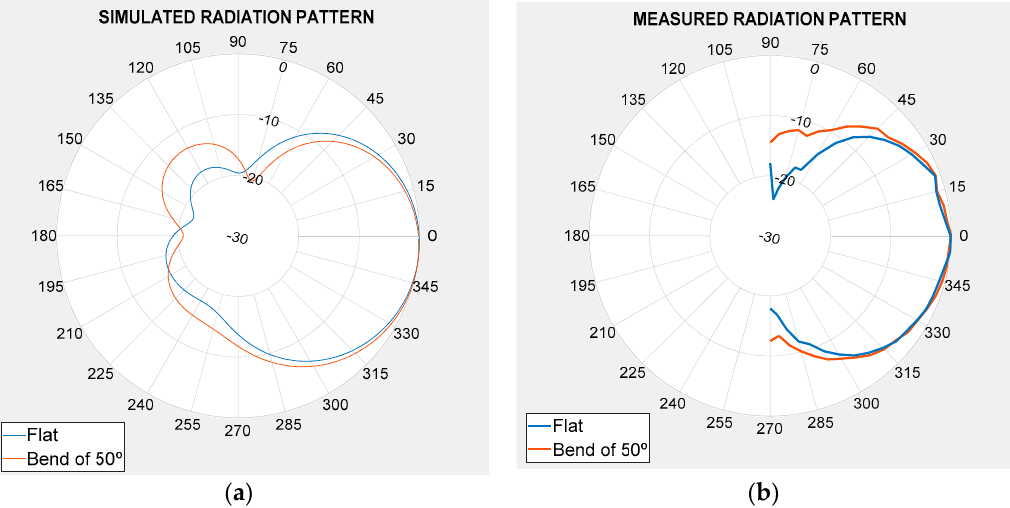
Figure 6. Radiation pattern of the 6 mm thickness antenna for flat and bend positions ( α = 50 ◦ ). ( a ) Simulation results and ( b ) measurement results.